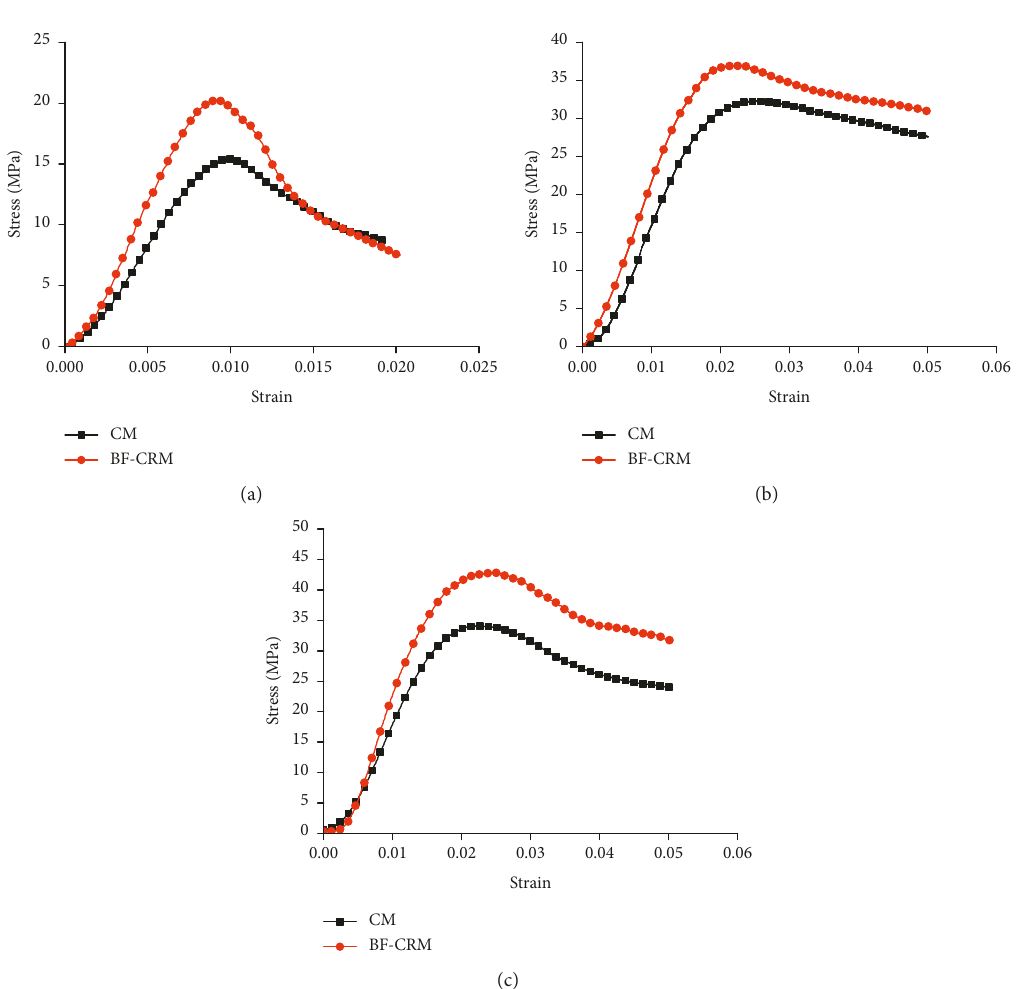
Figure 9: Stress-strain curve for the conventional triaxial pressure test: (a) 0 MPa; (b) 5 MPa; (c)